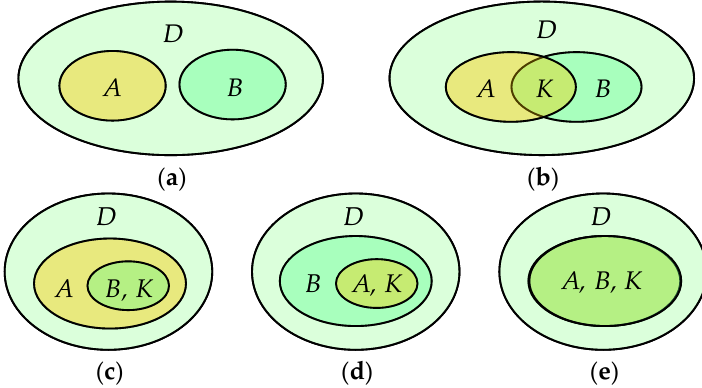
Figure 1. Interconnection of sets A and B in the system D : ( a ) There is no relation ( K = ∅ ); ( b ) a partial relation ( K (cid:44) ∅ , K (cid:44) A , K (cid:44) B ); ( c ) a partial relation ( K = B ⊂ A ); ( d ) a partial relation ( K = A ⊂ B ); ( e ) a one-to-one relation ( A = B = K